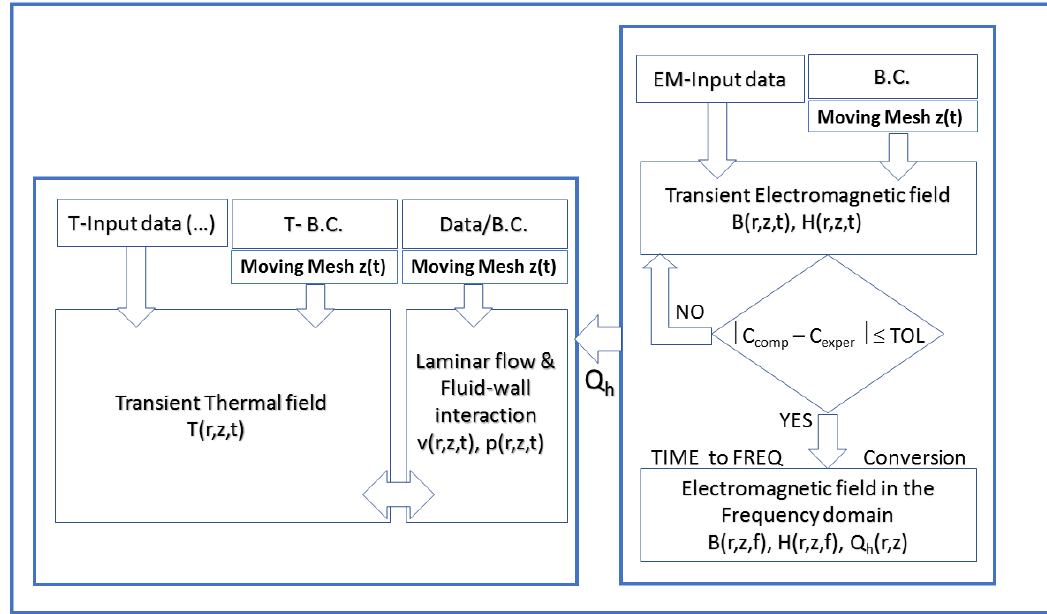
Figure 3. Field (module) coupling and Multiphysics flow of the finite element EC damper model.